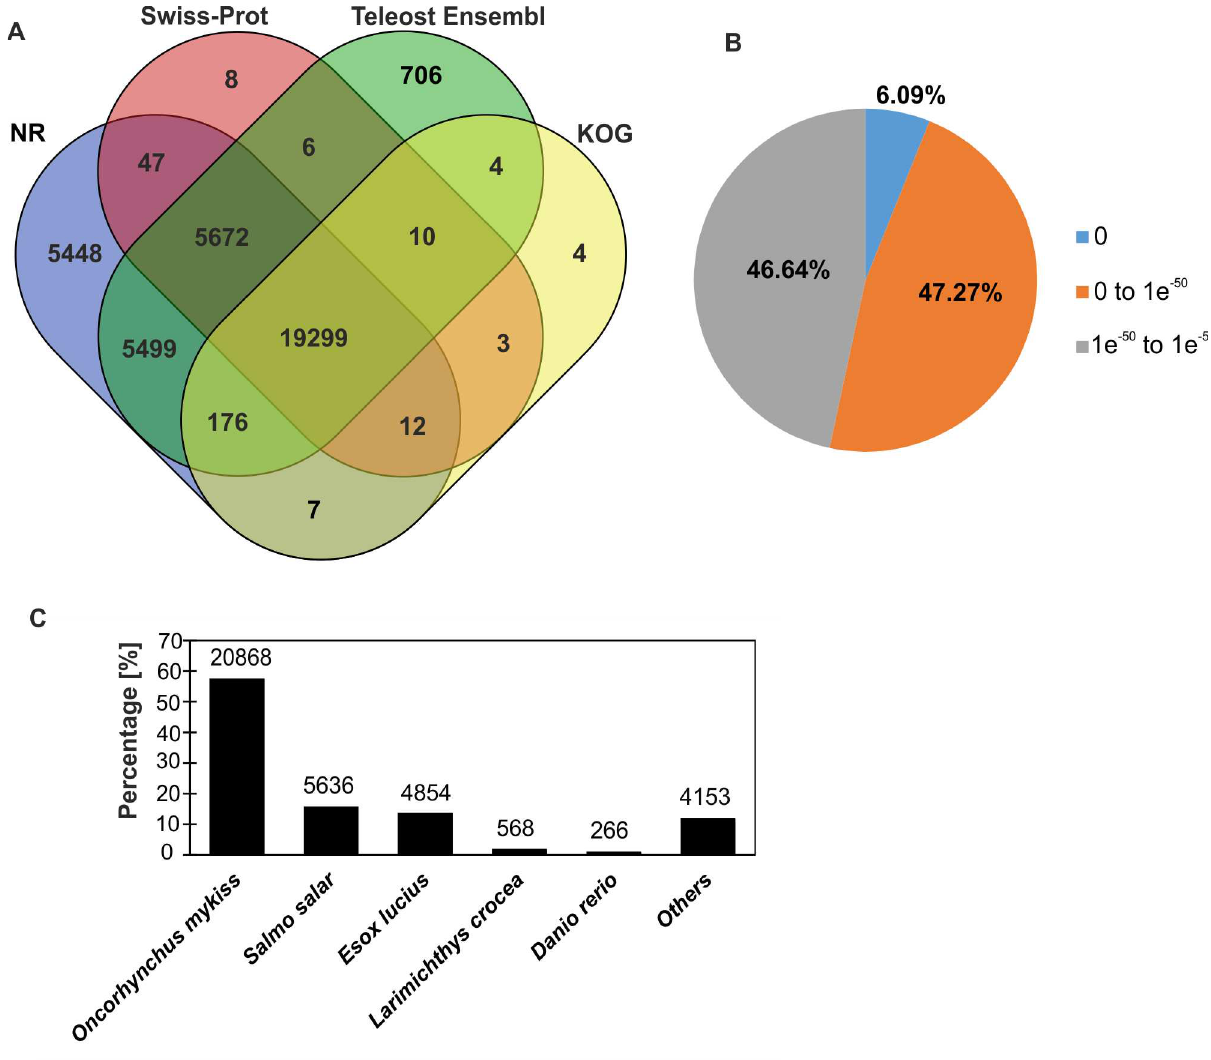
Fig 1. Characteristics of the homology search of sea trout transcripts. (A) Venn diagram illustrating the distributionof matches against four public databases (NCBI nr, Swiss-Prot, Teleost Ensembland KOG databases). In total, 36,902 (48.57%) transcripts were annotated. (B) E-value and (C) species distributionof the best hits based on the NCBI nr database.